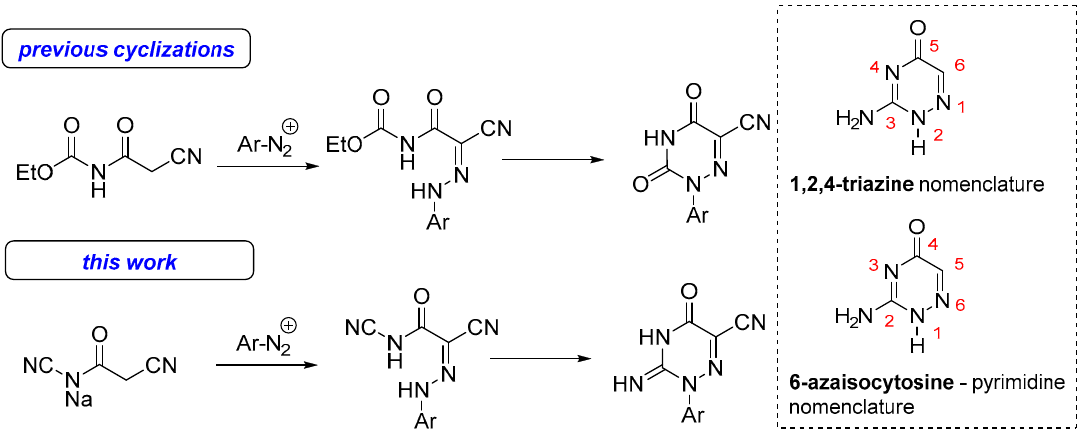
Figure 1. Schematic diagram of this work and atom numbering for the 6-azaisocytosine and 1,2,4-triazine skeletons.